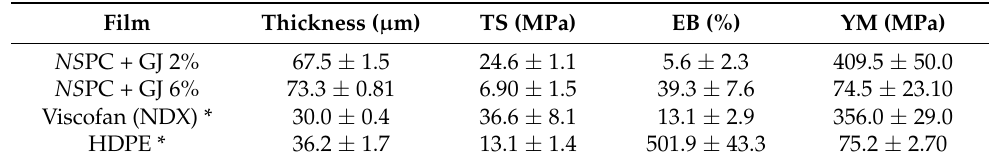
Table 2. Thickness and mechanical properties of some commercial materials and of NS DSC protein films incorporated with 2% and 6%